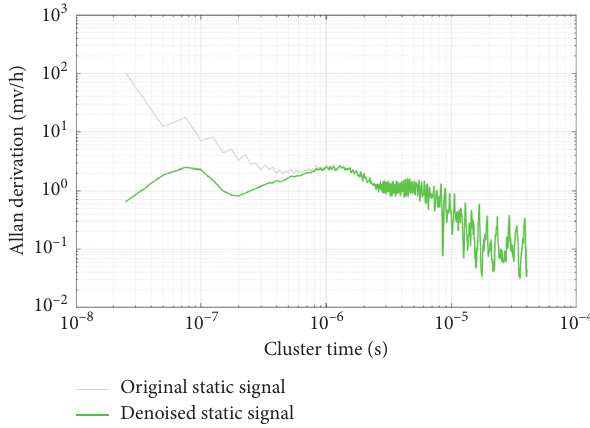
Figure 12: The denoising results of the preparation stage analyzed by Allan